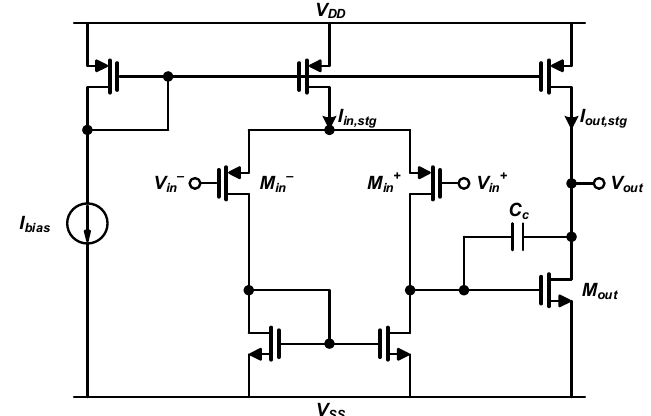
Figure 5. Circuit diagram of the 2-stage operational amplifier (OP-AMP) used in the charge-sensitive amplifier (CSA) and voltage buffer (BUF).